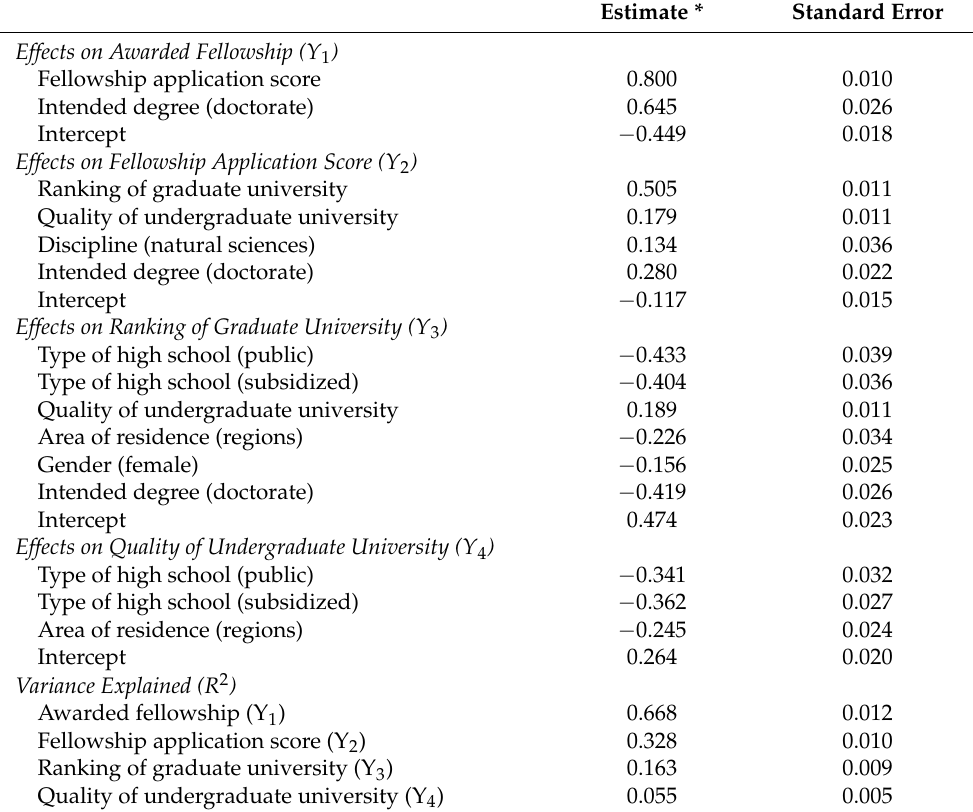
Table 3. Estimated direct effects on endogenous variables of the final